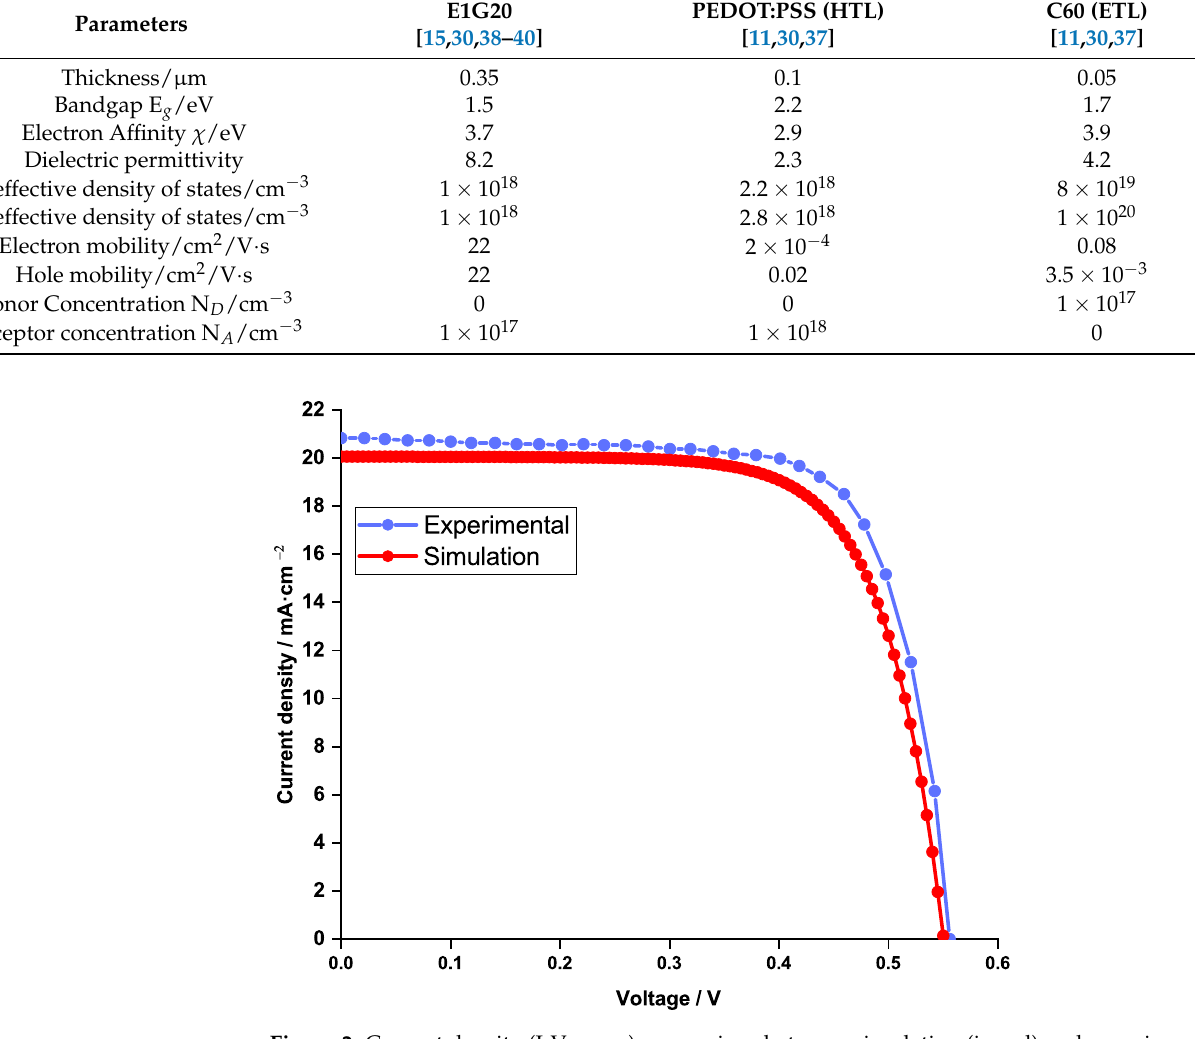
Figure 2. Current density (J-V curve) comparison between simulation (in red) and experimental (in blue) work. Table 2. Electrical and optical properties of different HTL